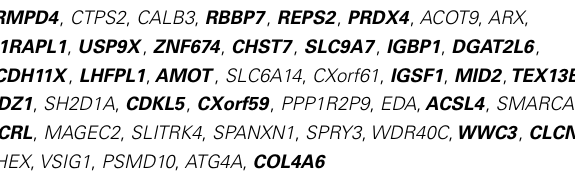
Table 7 | X-chromosome genes identified by trans-eQTL association with SST , GAD67, or GAD65 in human frontal